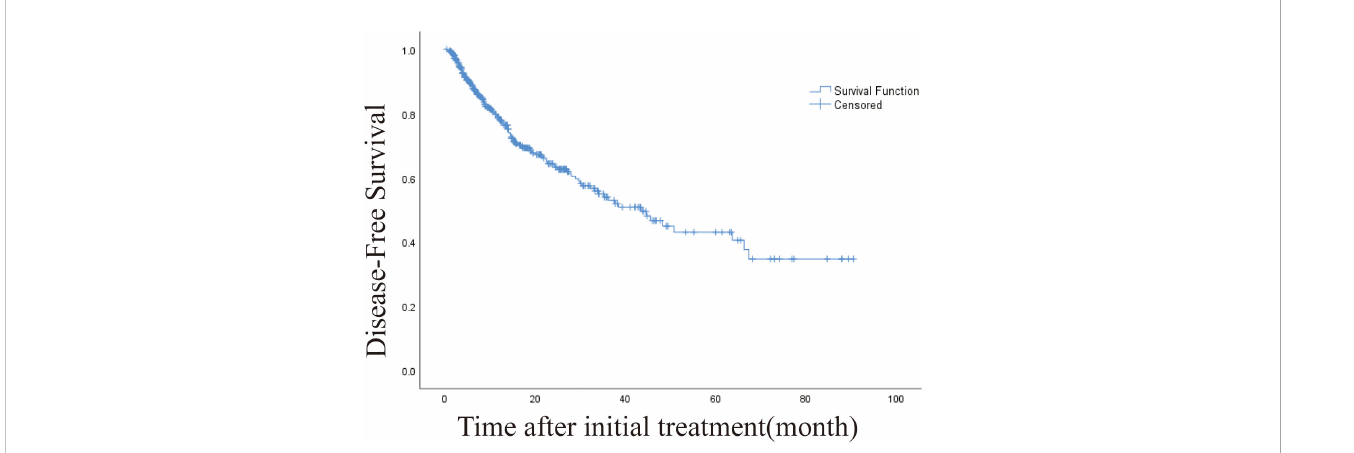
FIGURE 4 Kaplan-Meier curve of disease-free survival (DFS) in patients with primary liver cancer who underwent radiofrequency ablation (median DFS, 43.6 months).